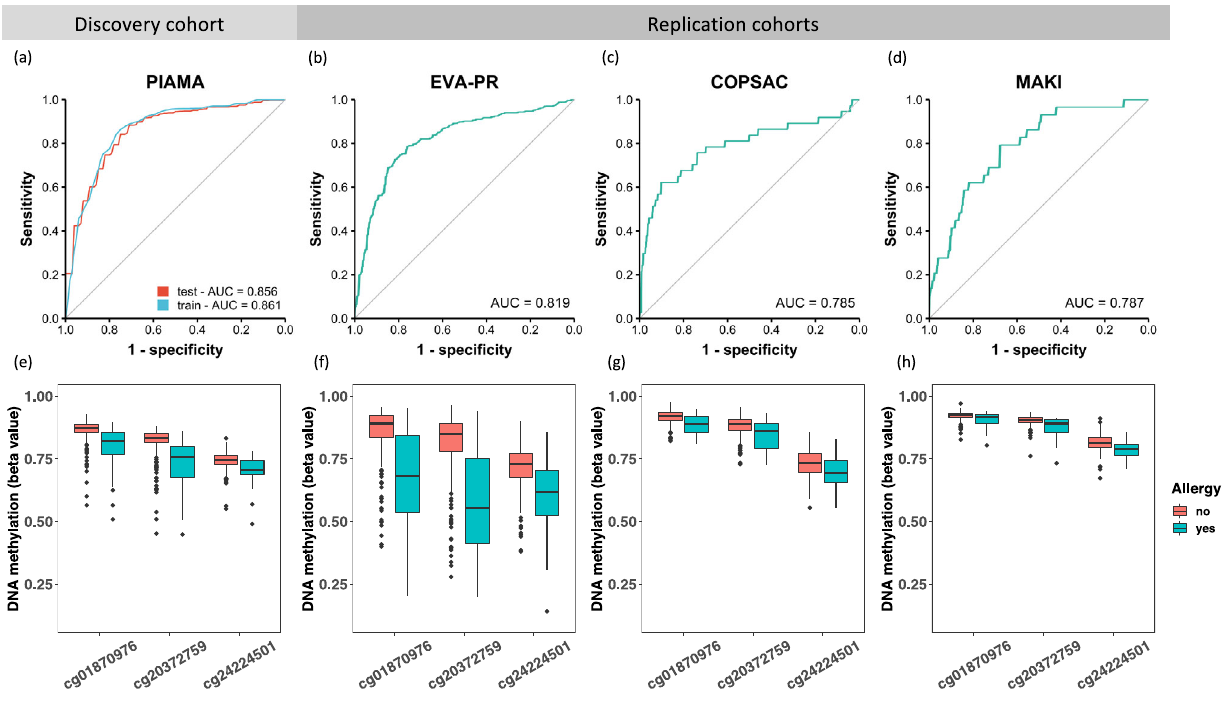
Fig. 3 | Model performance and feature distribution in the discovery and replicationcohorts. TheROCcurveandAUCofthemodelinthediscoverycohort ( a ) and replication cohorts: EVA-PR ( b , mean age 16 years), COPSAC2010 ( c , mean age 6 years), and MAKI ( d , mean age 6 years). The DNA methylation levels of the three CpG sites in participants with and without allergy are shown in ( e – h ), for